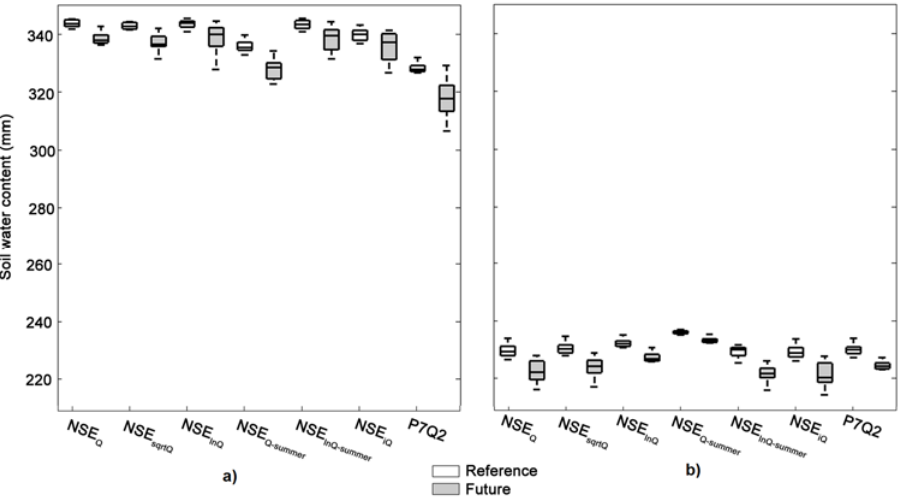
Figure 14. Median of soil water content during the summer simulated with the SWAT model for the ( a ) Cowansville sub-watershed; and ( b ) Noire River sub-watershed.